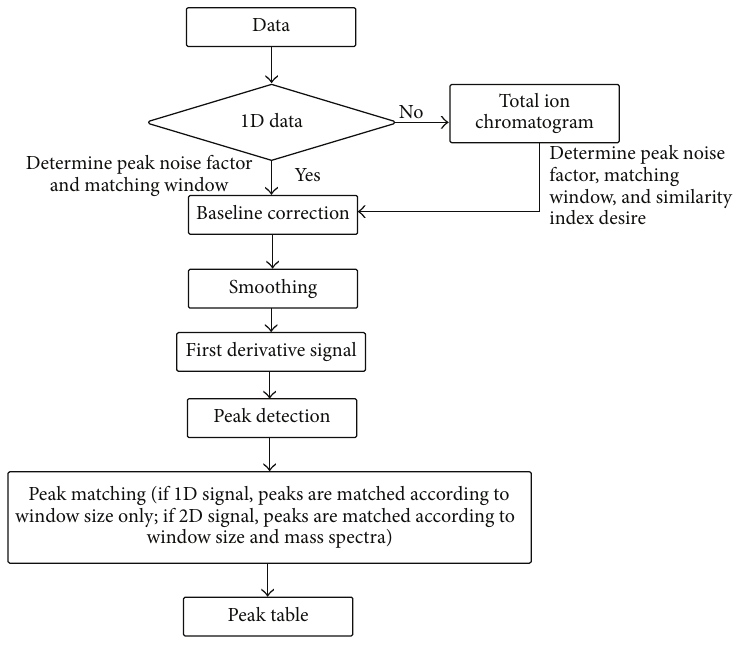
Figure 1: Schematic diagram of the synchronised